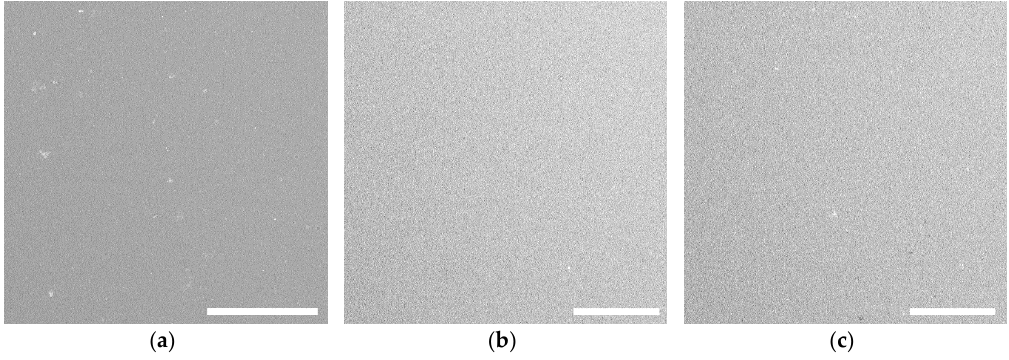
Figure 3. SEM images of the films cast from 2 wt % solutions of ( a ) HEC, ( b ) chitosan and ( c ) Figure3. SEMimagesofthefilmscastfrom2wt%solutionsof( a )HEC,( b )chitosanand( c )water-soluble water-soluble fraction of ChsHEC-2. Scale bar is 100 μ m. fraction of ChsHEC-2. Scale bar is 100 µ m.